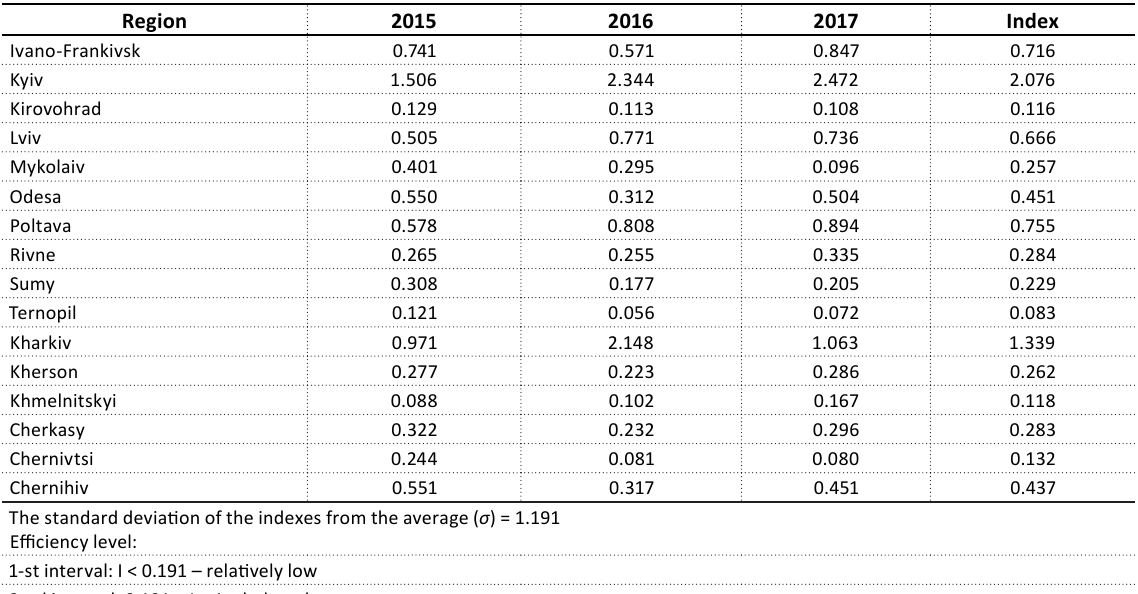
Table A3 (cont.). The dynamics of the integrated territorial index of the efficiency of the water resources management system at the territorial level by the investment criterion,